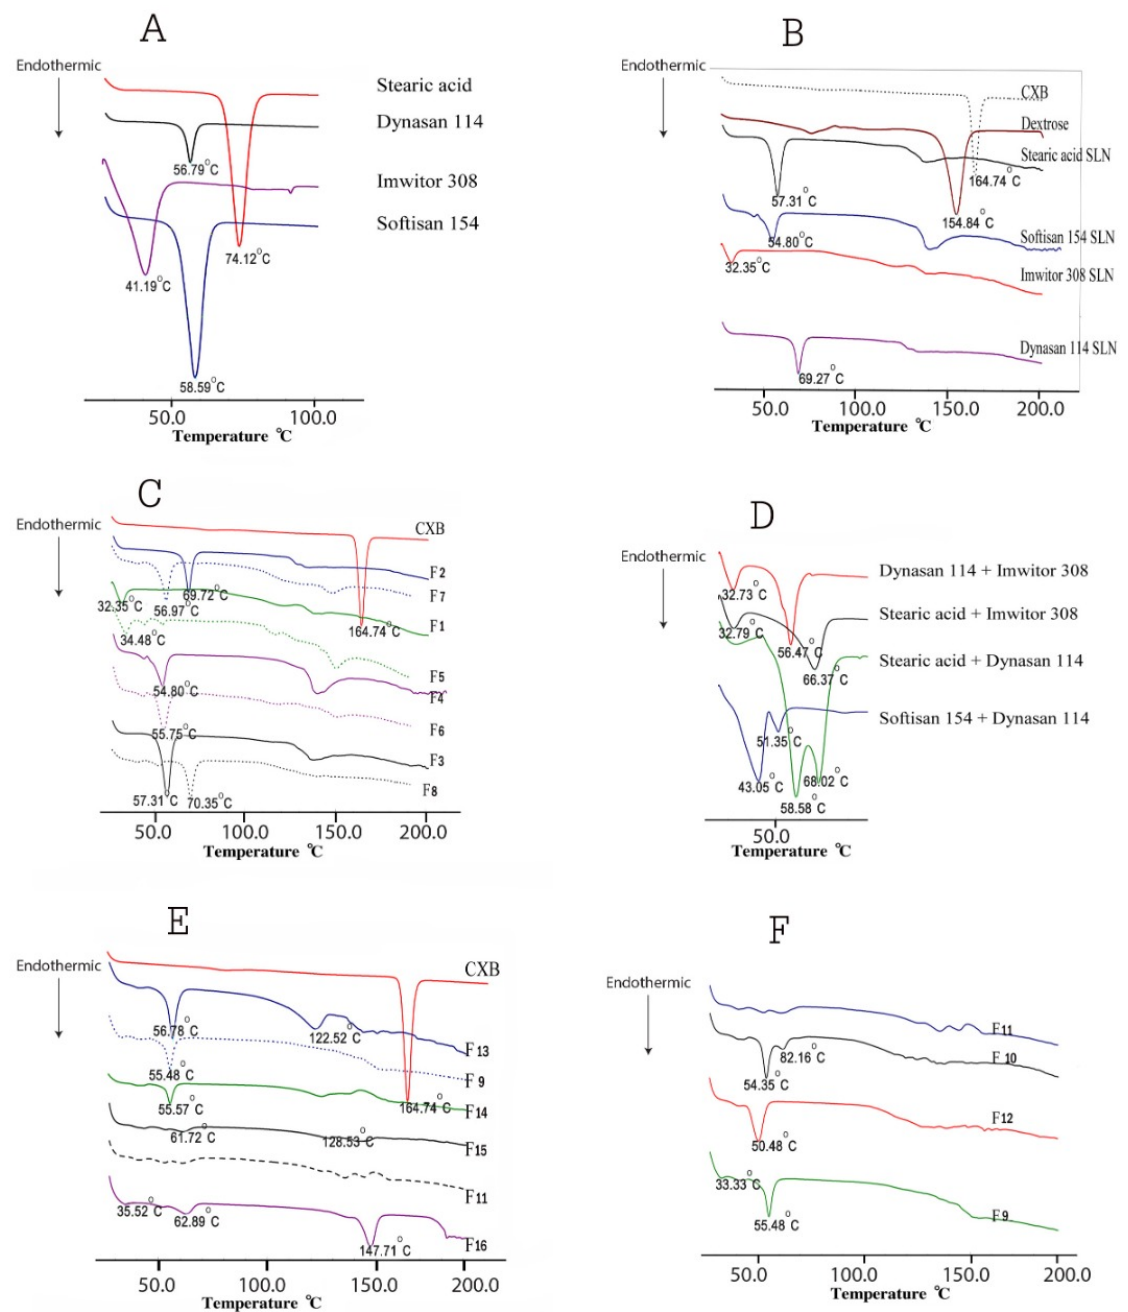
Figure 2. Differential scanning calorimetry for CXB, lipids, and all SLN formulations: ( A ) DSC thermograms of pure lipids: stearic acid, Dynasan 114, Imwitor 308 and Softisan 154, ( B ) DSC thermograms of pure CXB, dextrose and unloaded SLN formulations containing single lipid, ( C ) DSC thermograms of SLN formulations F1–F8, ( D ) DSC thermograms of unloaded SLN formulations containing various double ‐ lipid combinations, ( E ) DSC thermograms of F9, F11 and F13–F16: double ‐ lipid combination SLN formulations with various surfactant combinations, ( F ) DSC thermograms of F9–F12: double ‐ lipid combination SLN formulations using the same surfactant combination.